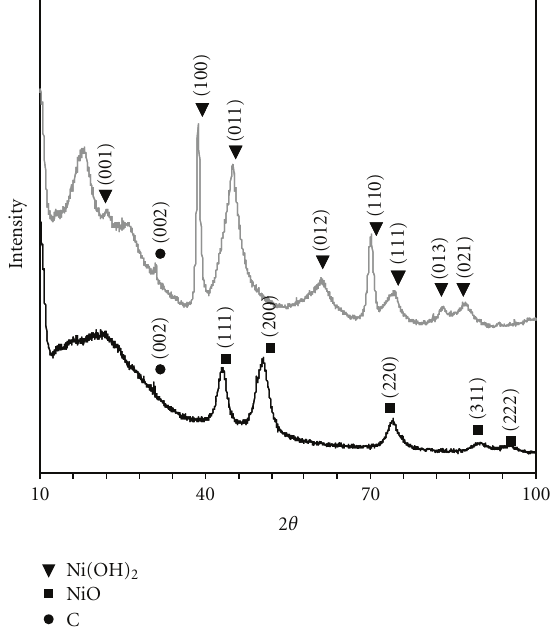
Figure 1: XRD pattern of the deposited nickel hydroxide on AC and nickel oxide on AC.